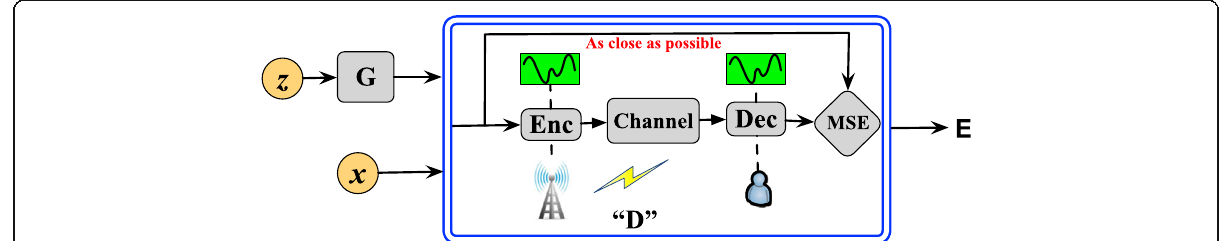
Fig. 7 EBGAN with an autoencoder discriminator in wireless